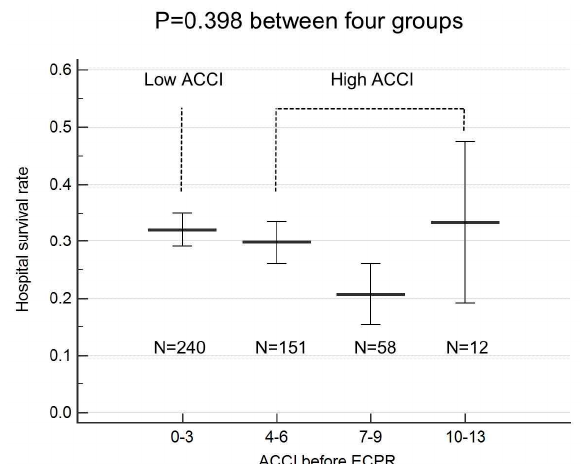
Figure A1. Hospital survival rate grouped by age-adjusted Charlson comorbidity index (ACCI) before extracorporeal cardiopulmonary resuscitation (ECPR). Table A1. Contraindications of extracorporeal cardiopulmonary resuscitation (ECPR). Absolute contraindication